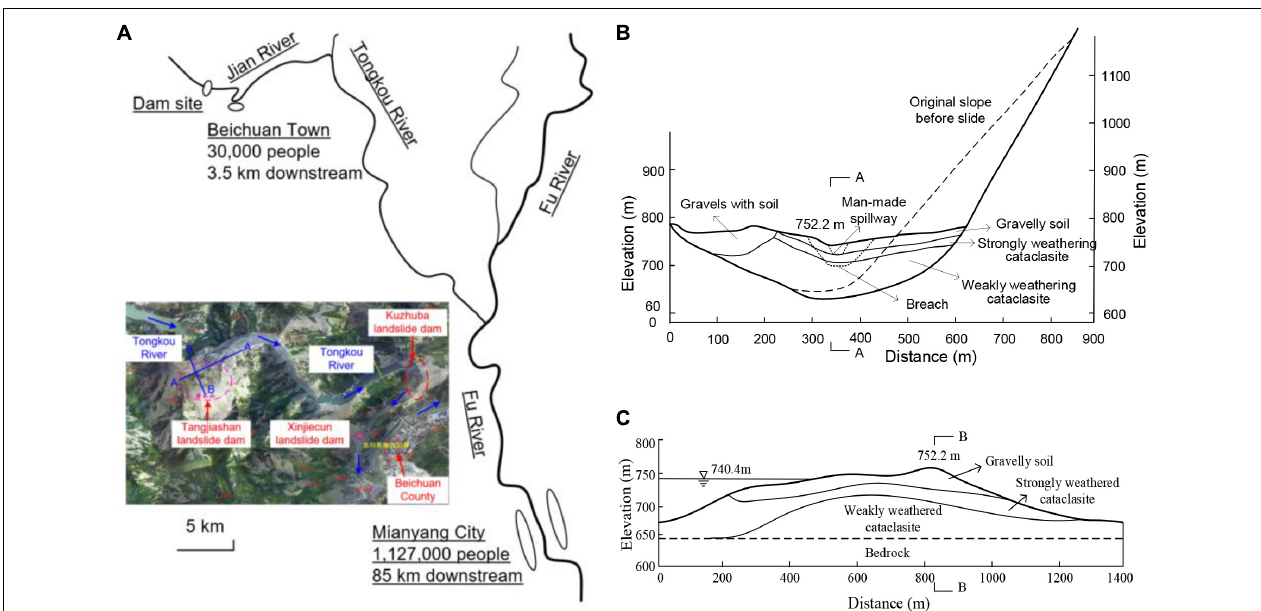
FIGURE 4 | The location and cross section of the Tangjiashan landslide dam: (A) the location of the dam and the Beichuan Town; (B) the cross section across the river; and (C) the cross section along the river.